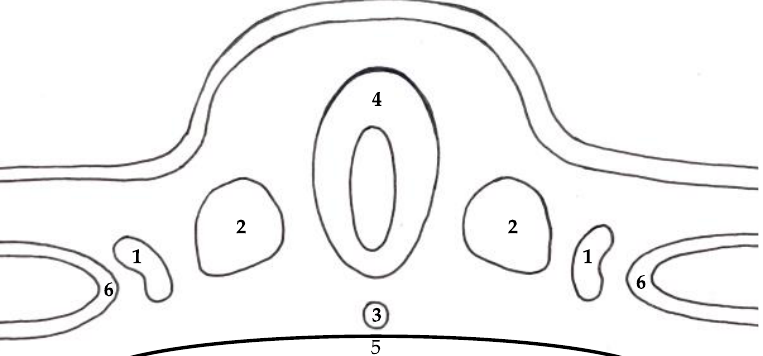
Figure 1. Structures in the dorsal part of the embryo: (1) intermediate mesoderm, (2) paraxial mesoderm, (3) notochord, (4) neural tube, (5) yolk sac, (6) lateral plate. During the process of embryogenesis, the metanephric mesenchyme and ureteric buds become ureters, renal pelvis, major and minor calyces and collecting tubules. These structures migrate cranially towards the final localization of the permanent kidney (Fig- ure 2) [3].